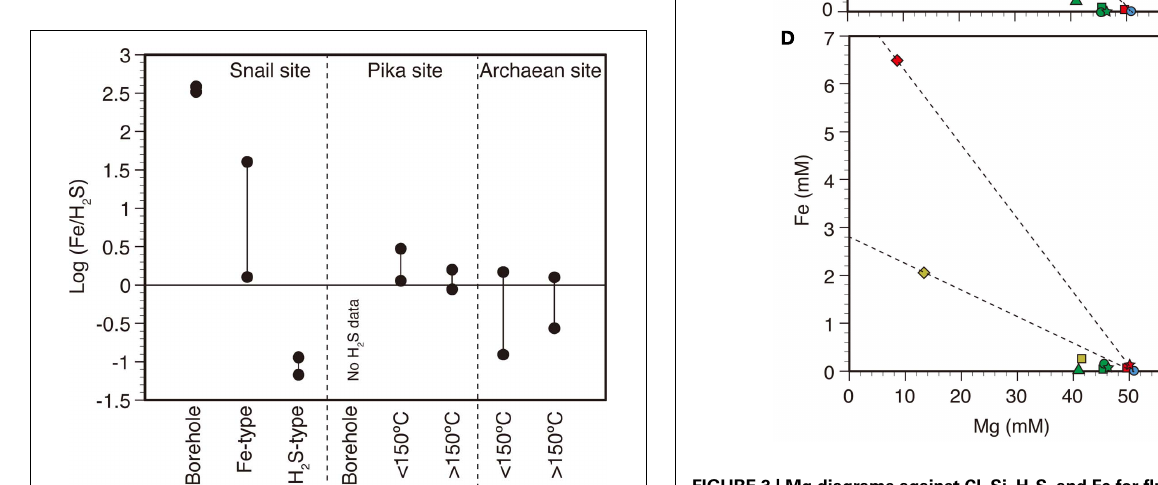
FIGURE 3 | Mgdiagrams against Cl, Si, H 2 S, and Fe for fluid samples. (A) Cl–Mg, (B) Si–Mg, (C) H 2 S–Mg, and (D) Fe–Mg diagrams are shown. NV and BH indicate natural vents and borehole fluids,